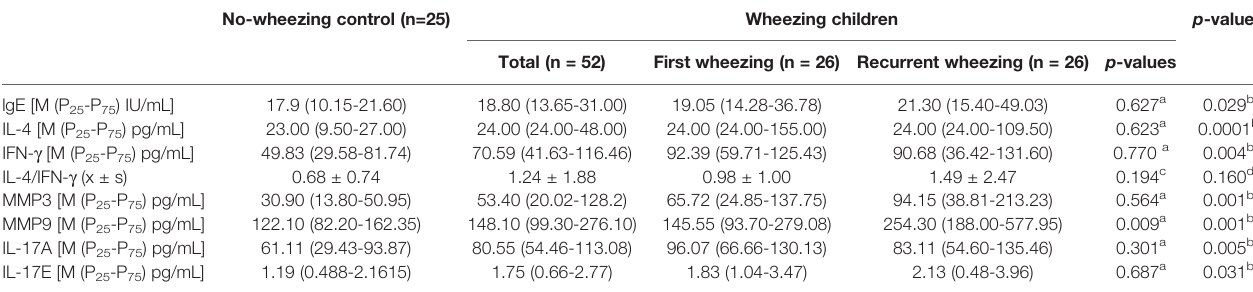
a Rank sum test for comparison of fi rst wheezing group versus recurrent wheezing group. b Rank sum test for comparison of wheezing group versus no-wheezing control. c ANOVA for comparison between fi rst wheezing and recurrent wheezing patients. d ANOVA for comparison between no-wheezing control and wheezing infants. In recent years, the incidence of wheezing is increasing year by year. Over half of children wheezing break out repeatedly, and breathing and the immune system to mature in infants and young children period, the period of recurrent wheezing may help children to adversely affect the body ’ s immune system and respiratory system, after treatment the most infant wheezing can alleviate, but about 50% of children with recurrent wheezing can develop bronchial asthma for children. As the symptoms of wheezing and the corresponding risk factors in children change over time, there are certain limitations. Therefore, it is important to explore the association between the pathogenesis of wheezing diseases and the pathogenesis of asthma. The essence of pediatric bronchial asthma is chronic airway in fl ammation, and Th1/Th2 imbalance is a widely accepted theory. MMP3, MMP9, and IL-17 are involved in airway remodeling of childhood asthma, and in our study they are also involved in the pathogenesis of infant wheezing disease, which provide more experimental basis for prevention and treatment of